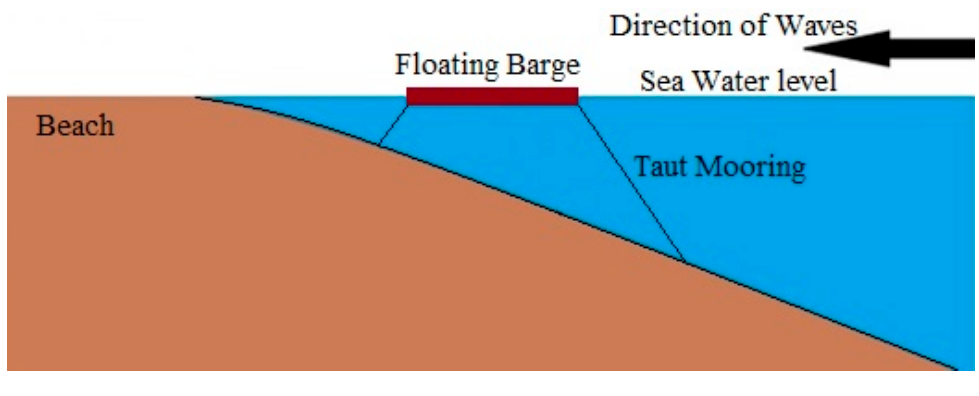
Figure 5. Barge moored to the seafloor.